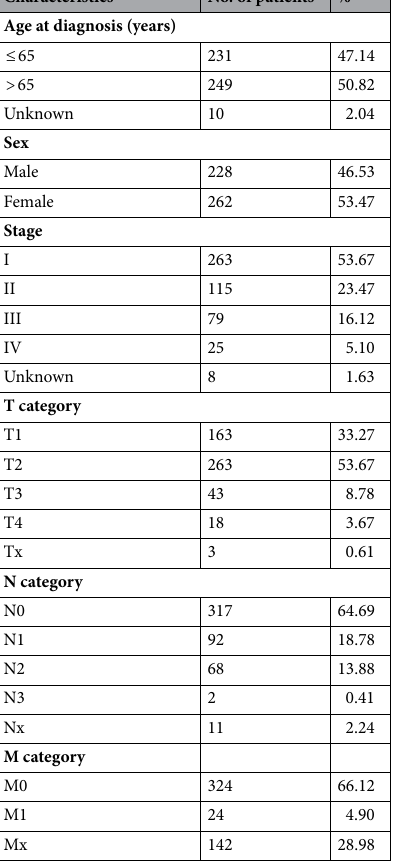
Table 1. Characteristics of patients with LUAD from TCGA database. LUAD, lung adenocarcinoma; TCGA, The Cancer Genome